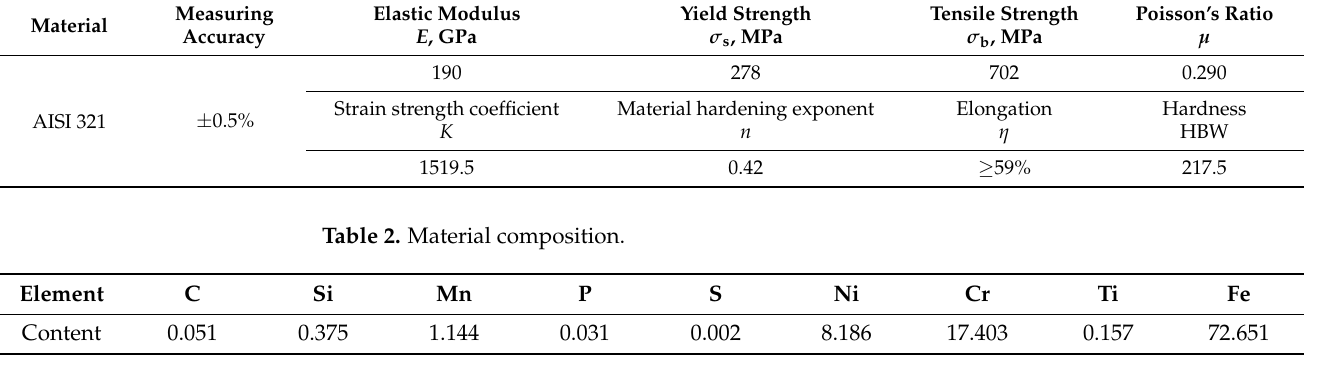
Figure 7. Composition and hardness analysis of AISI 321. Table 1. Material mechanical property parameters.